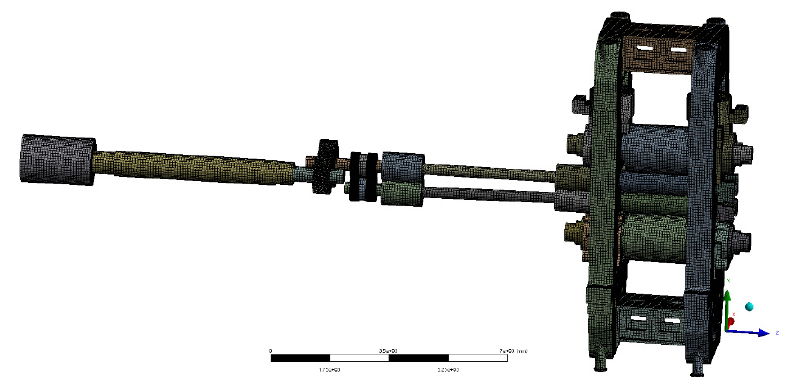
Figure 3. F3 frame model .